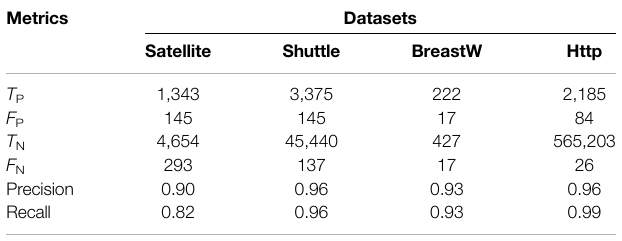
TABLE 2 | The results of the proposed method with outlier detection datasets.